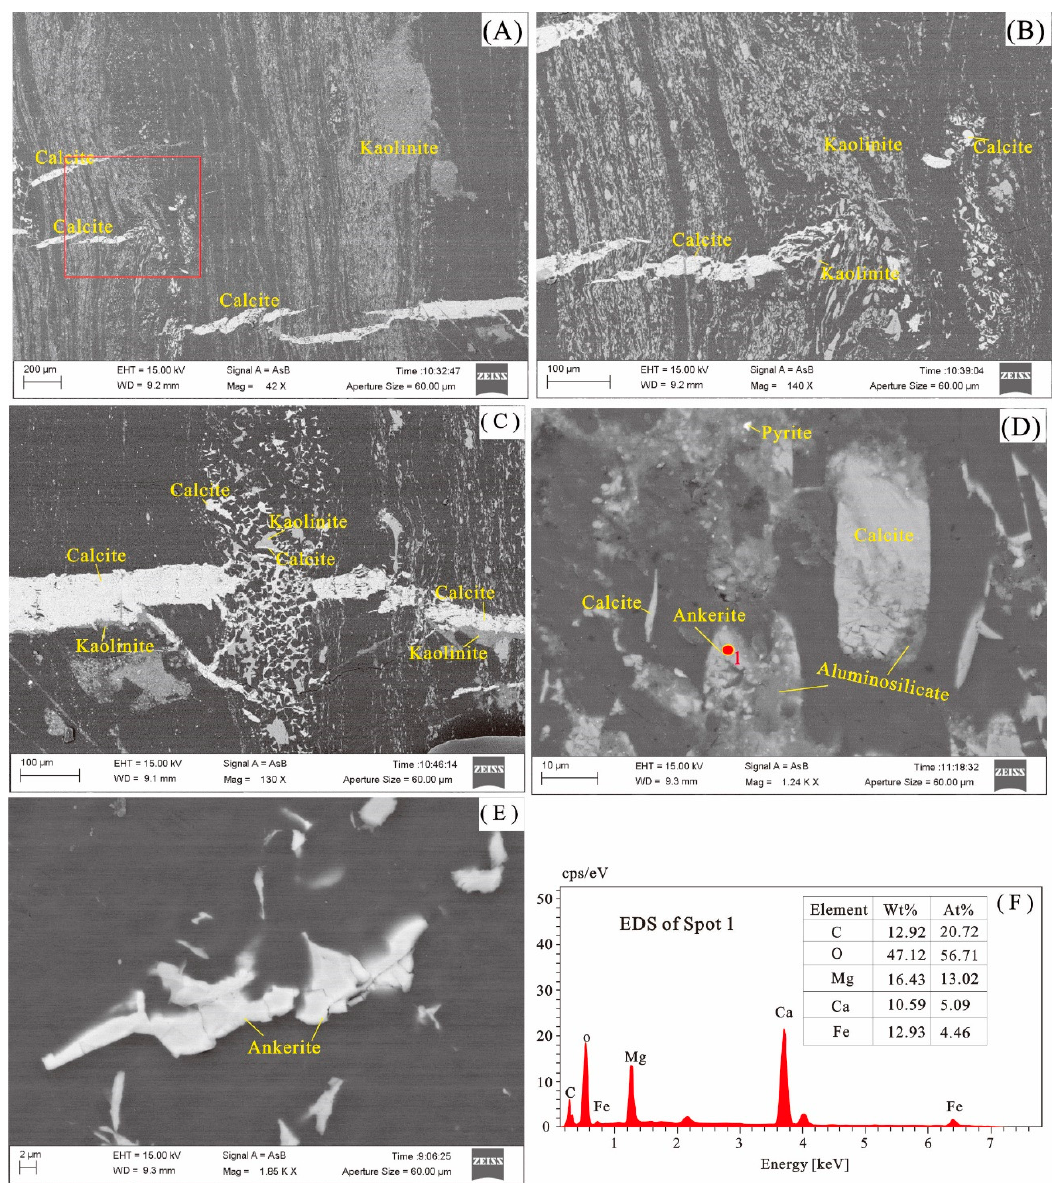
Figure 6. SEM backscattered images of the minerals in the samples from Dongpo Mine. ( A ) Kaolinite and fracture-filling calcite in sample DP5 -2 -5. ( B ), Magnification of the relationship between kaolinite and calcite in the red rectangle in Figure 6A. ( C ) Calcite and kaolinite in sample DP5 -2 -5. ( D ) Calcite, ankerite, pyrite, and aluminosilicate in sample DP5 -2 -4. ( E ) Fracture-filling ankerite in sample DP5 -2 -6. ( F ) EDS spectrum of Spot 1.